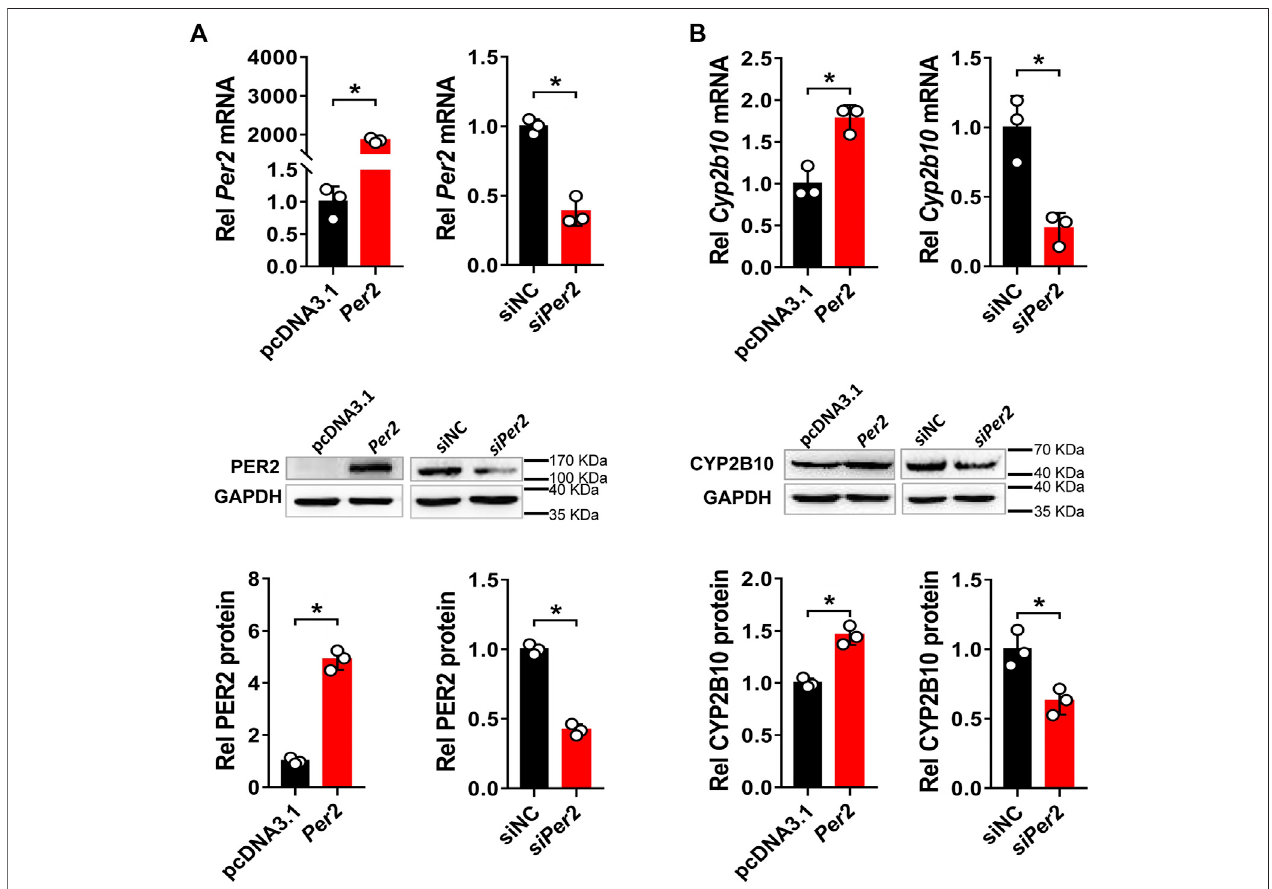
FIGURE 6 | Per2 regulates CYP2B10 expression in Hepa-1c1c7 cells. (A) Ef fi cacy validation of Per2 overexpression (by overexpression plasmid) and knockdown (by siRNA). (B) Effects of Per2 overexpression or knockdown on the expression of CYP2B10 mRNA and protein. Western blot strips (a target protein and a loading control) were cut from one gel. Data are mean ± SD from three independent experiments. * p < 0.05 (t test). Rel,